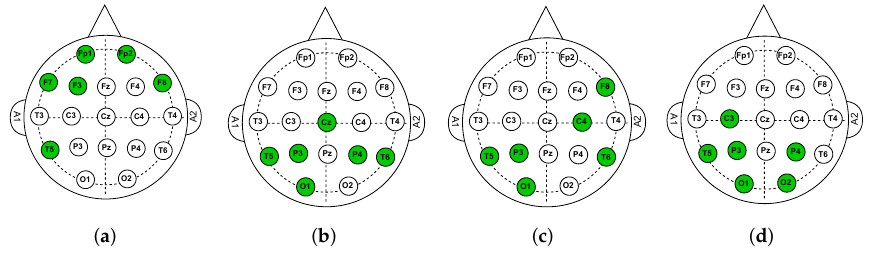
Figure 5. Spatial maps of discriminant channel subsets for individual subjectsA , B , C , and F .